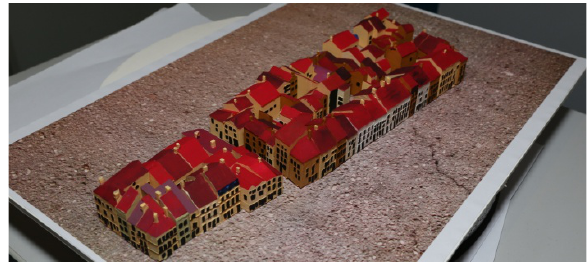
Fig. 1. Two printed city block from the Toul scale